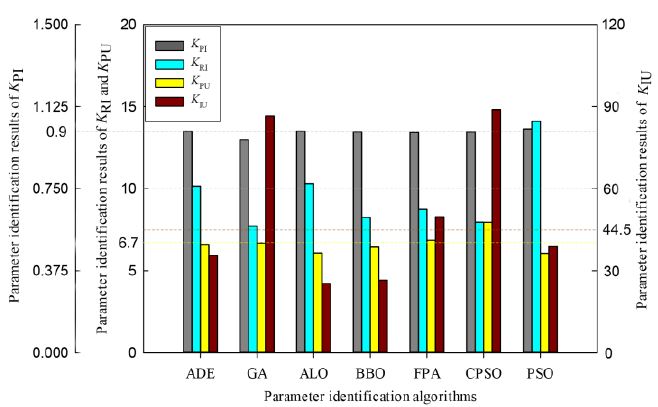
Figure 14. Parameters identification results of different heuristic algorithms.